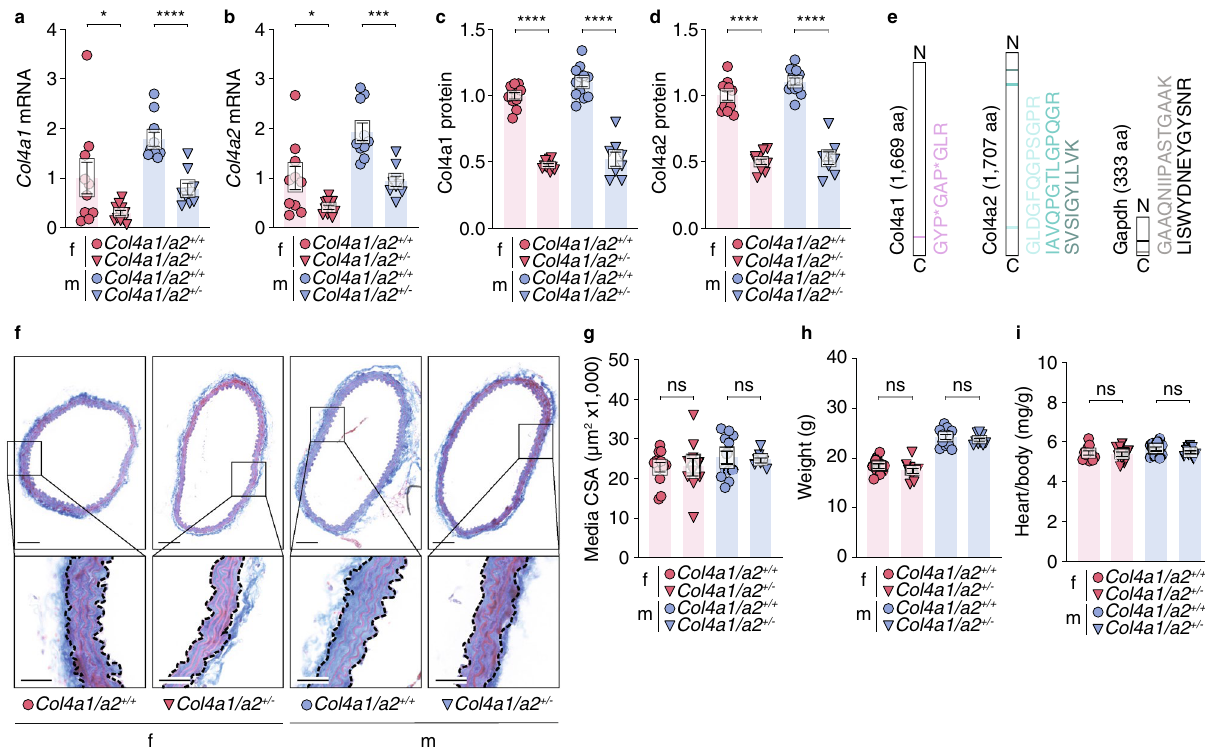
Figure 1. Col4a1/a2 hemizygosity reduces aorta Col4a1/a2 content but does not affect morphometry of the aorta. ( a , b ) Aorta Col4a1 ( a ) and Col4a2 ( b ) mRNA levels relative to Gapdh measured by qPCR. ( c , d ) Aorta Col4a1 ( c ) and Col4a2 ( d ) protein levels relative to Gapdh measured by MRM LC–MS. For ( a – d ), data are normalized to the mean of the female Col4a1/a2 + / + group. ( e ) Peptides (and their location) of Col4a1, Col4a2 and Gapdh from the MRM LC–MS analysis used to obtain results in ( c , d ). P* = hydroxyproline, aa = amino acids. ( f ) Representative cross-sections of aortas stained by Masson trichrome. Scalebars (overview) = 100 µm; Scalebars (magnifications) = 25 µm. ( g ) Quantitation of aorta media cross-sectional area (analysis is based on Acta2-stained aorta sections exemplified in Supplementary Fig. 1). ( h , i ) Weight ( h ) and relative heart mass ( i ) of baseline Col4a1/a2 + /− mice and Col4a1/a2 + / + littermates. Data are presented as mean ± SEM. * p ≤ 0.05, *** p ≤ 0.001, **** p ≤ 0.0001, ns = non-significant. Unpaired t-test was used in a-d and g-i. Although both sexes are plotted, no intersex comparisons were performed. f = female, m = male. n per group =